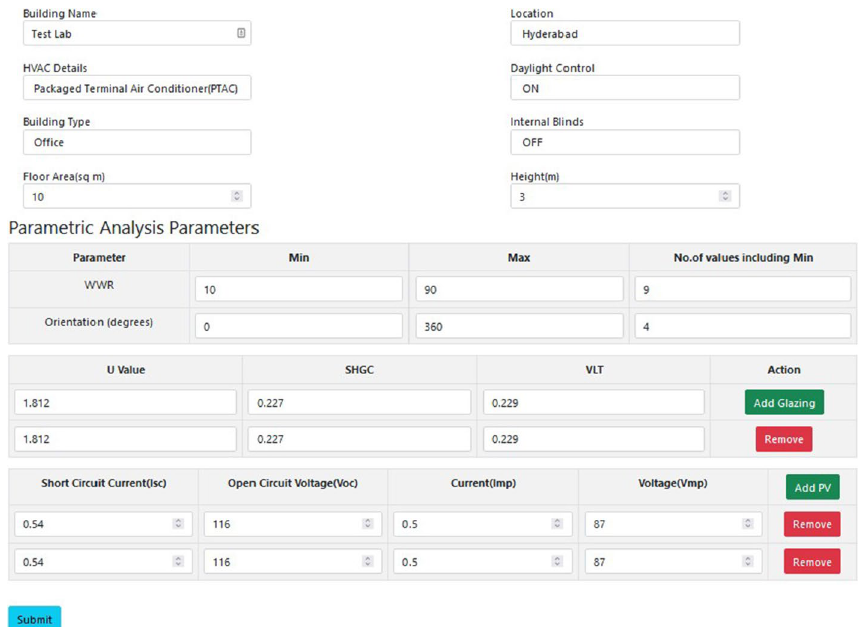
Fig. 2 User interface of the